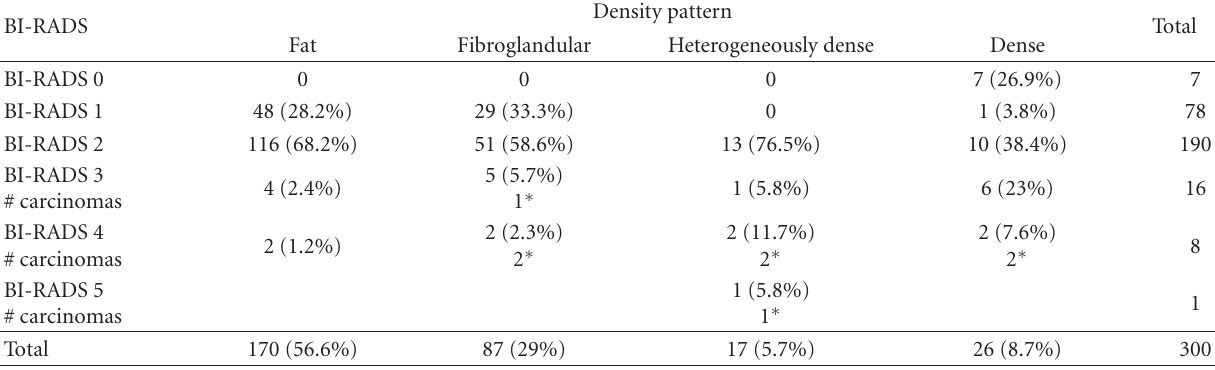
Density pattern Fibroglandular